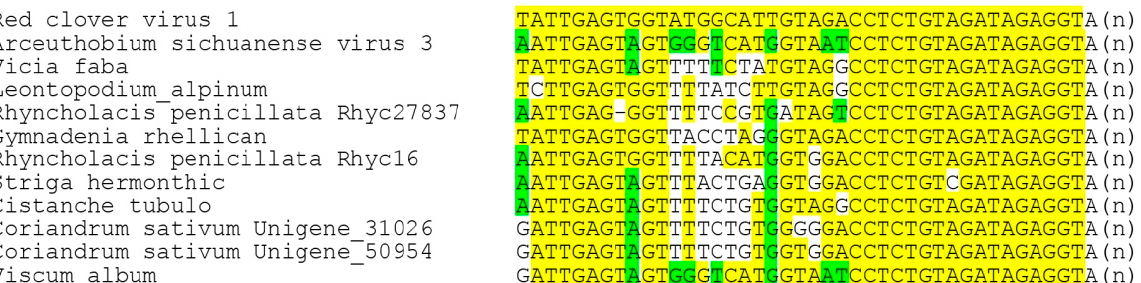
Figure 6. Pairwise nucleotide sequence alignment of the 3 ′ -terminal regions preceding poly(A) in the predicted VLRA RNAs of binamovirids. Conserved nucleotides and RNA blocks are highlighted by yellow background. AAA at the 3’-terminus means poly(A) tract.